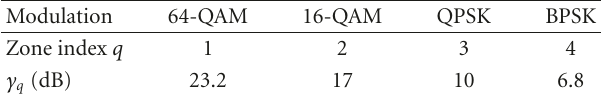
Table 3: Available modulations’ SNR thresholds for b = 10 − 3 .